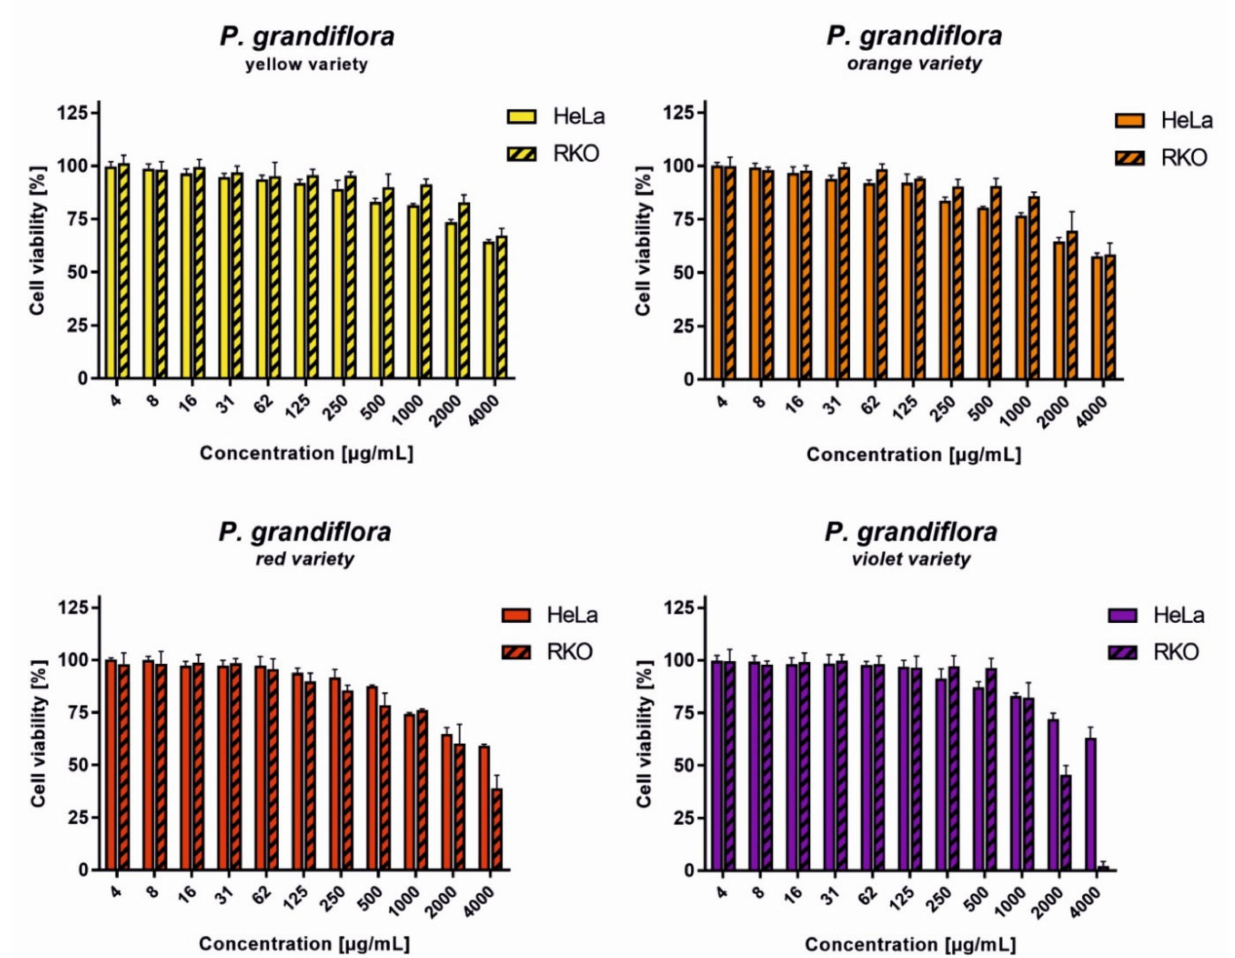
Figure 4. The dose-response activity of P. grandiflora extracts on cancer cell lines after 24 h